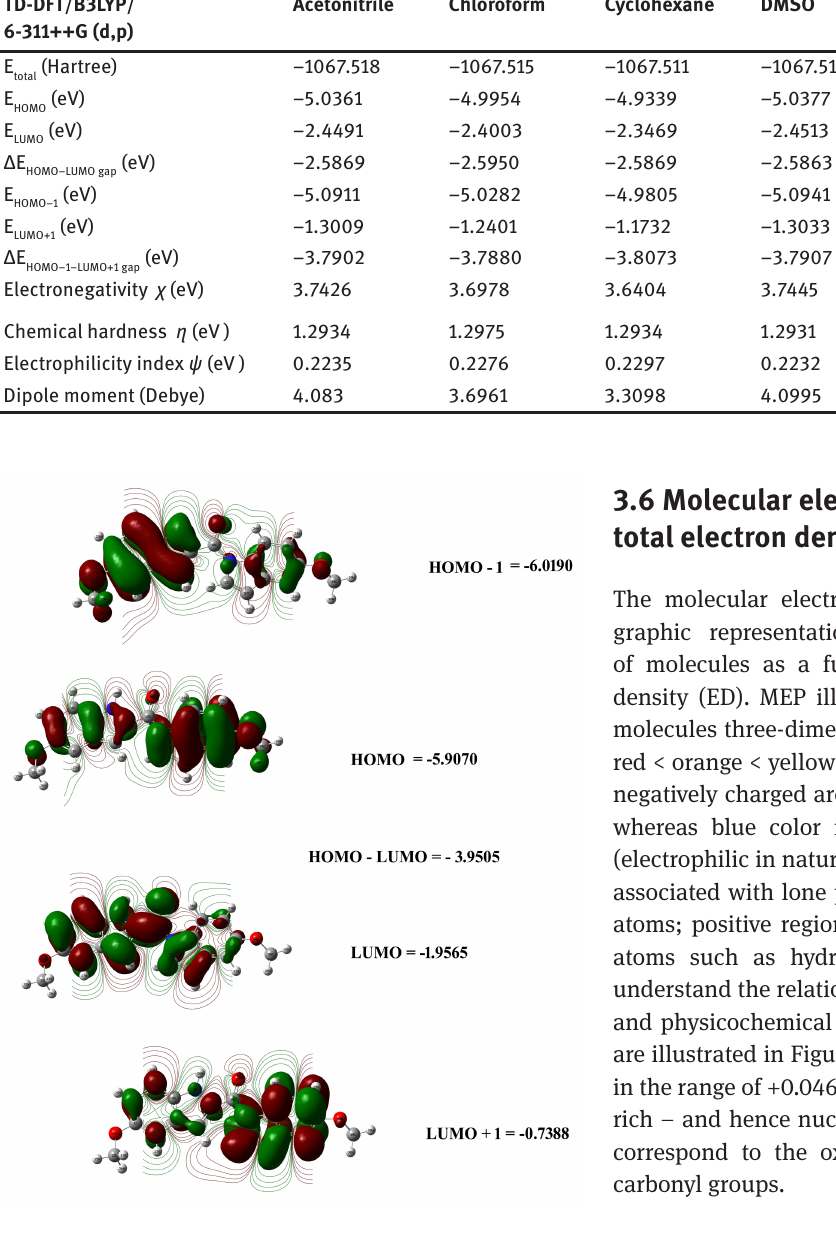
Figure 4 : Molecular orbitals and energies of MIMIM (PBEPBE